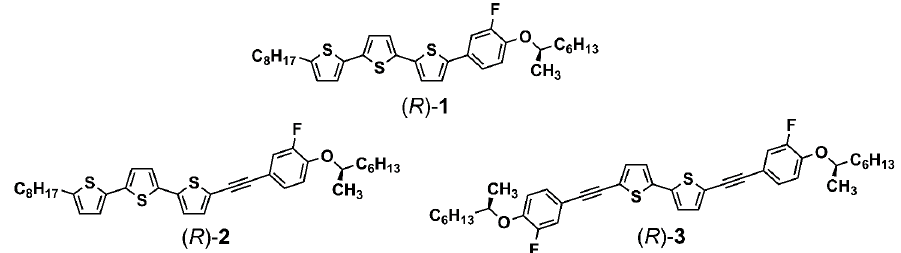
Figure 1. Chemical structures of the chiral π -conjugated compounds ( R )- 1 , ( R )- 2 , and ( R )- 3